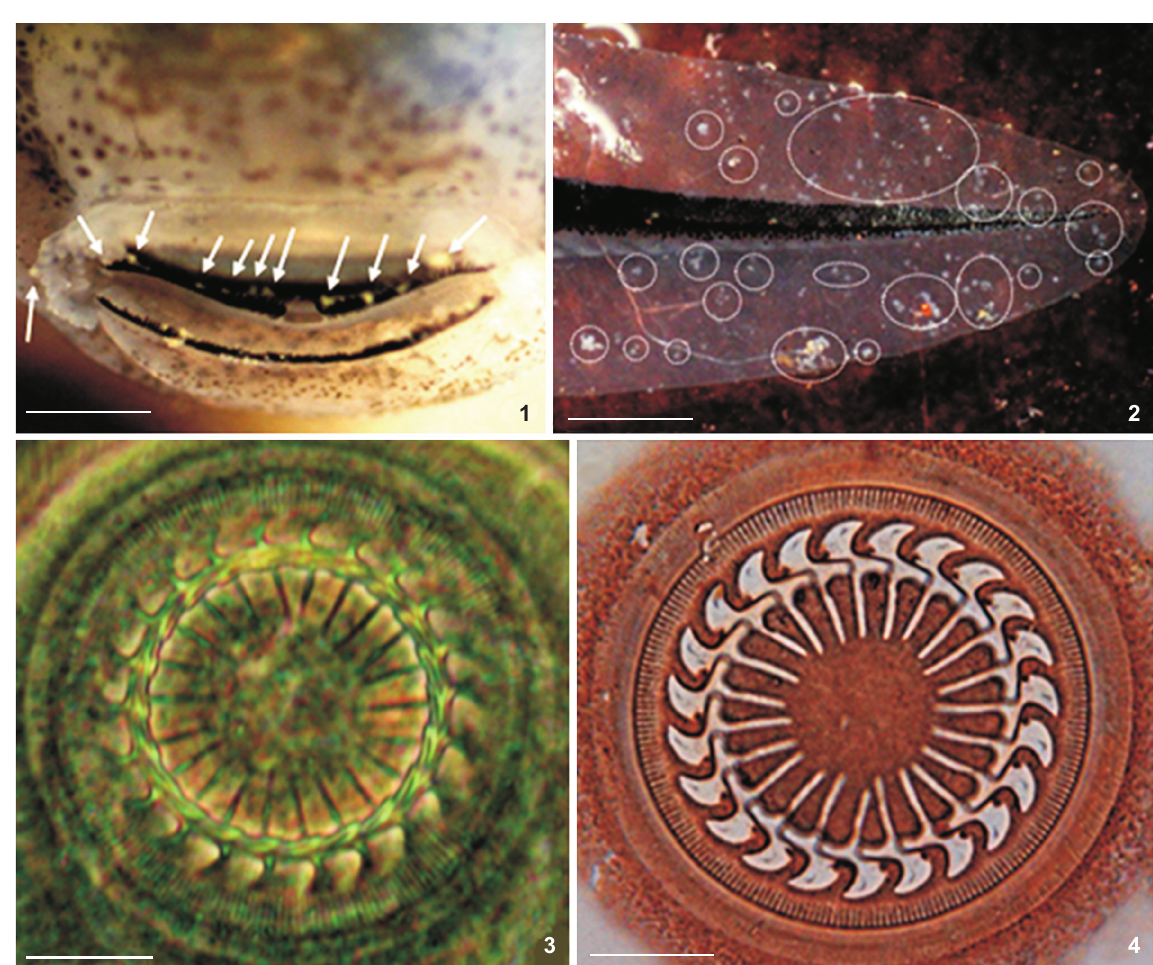
Figs 1-4. Trichodina heterodentata infesting tadpoles of a Brazilian toad Rhinella pombali . (1) Oral region of R. pombali infested by T. heterodentata , arrows indicates attached parasites. (2) Trichodinids infesting the tadpole tail. Highlighted white spots are the ectopara- sites. (3) Trichodina heterodentata from life. (4) Details of the T. heterodentata adhesive disk evidenced by silver-impregnation method (Klein, 1958). Scale bars: 1-2 = 1cm; 3-4 = 20 µm.